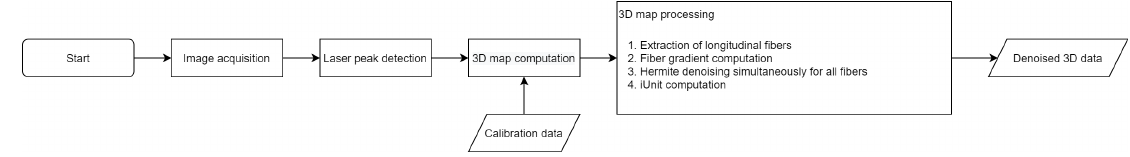
Figure 1. Flowchart of the computational process carried out by the